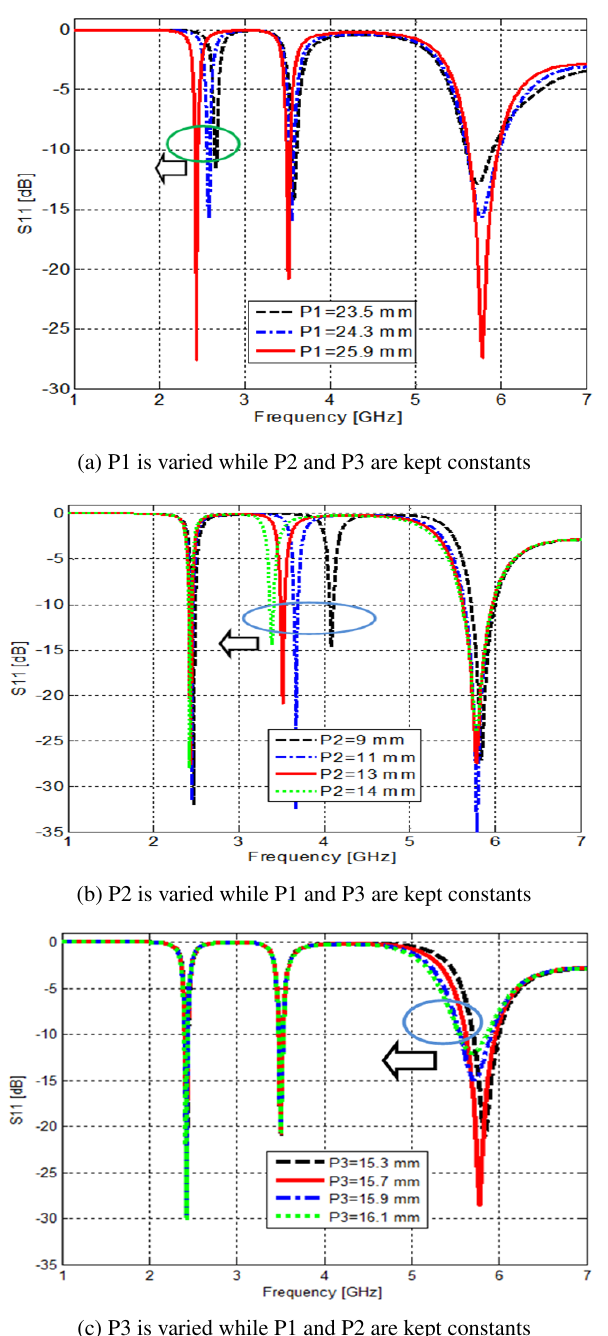
Figure 5: Return losses of the proposed antenna